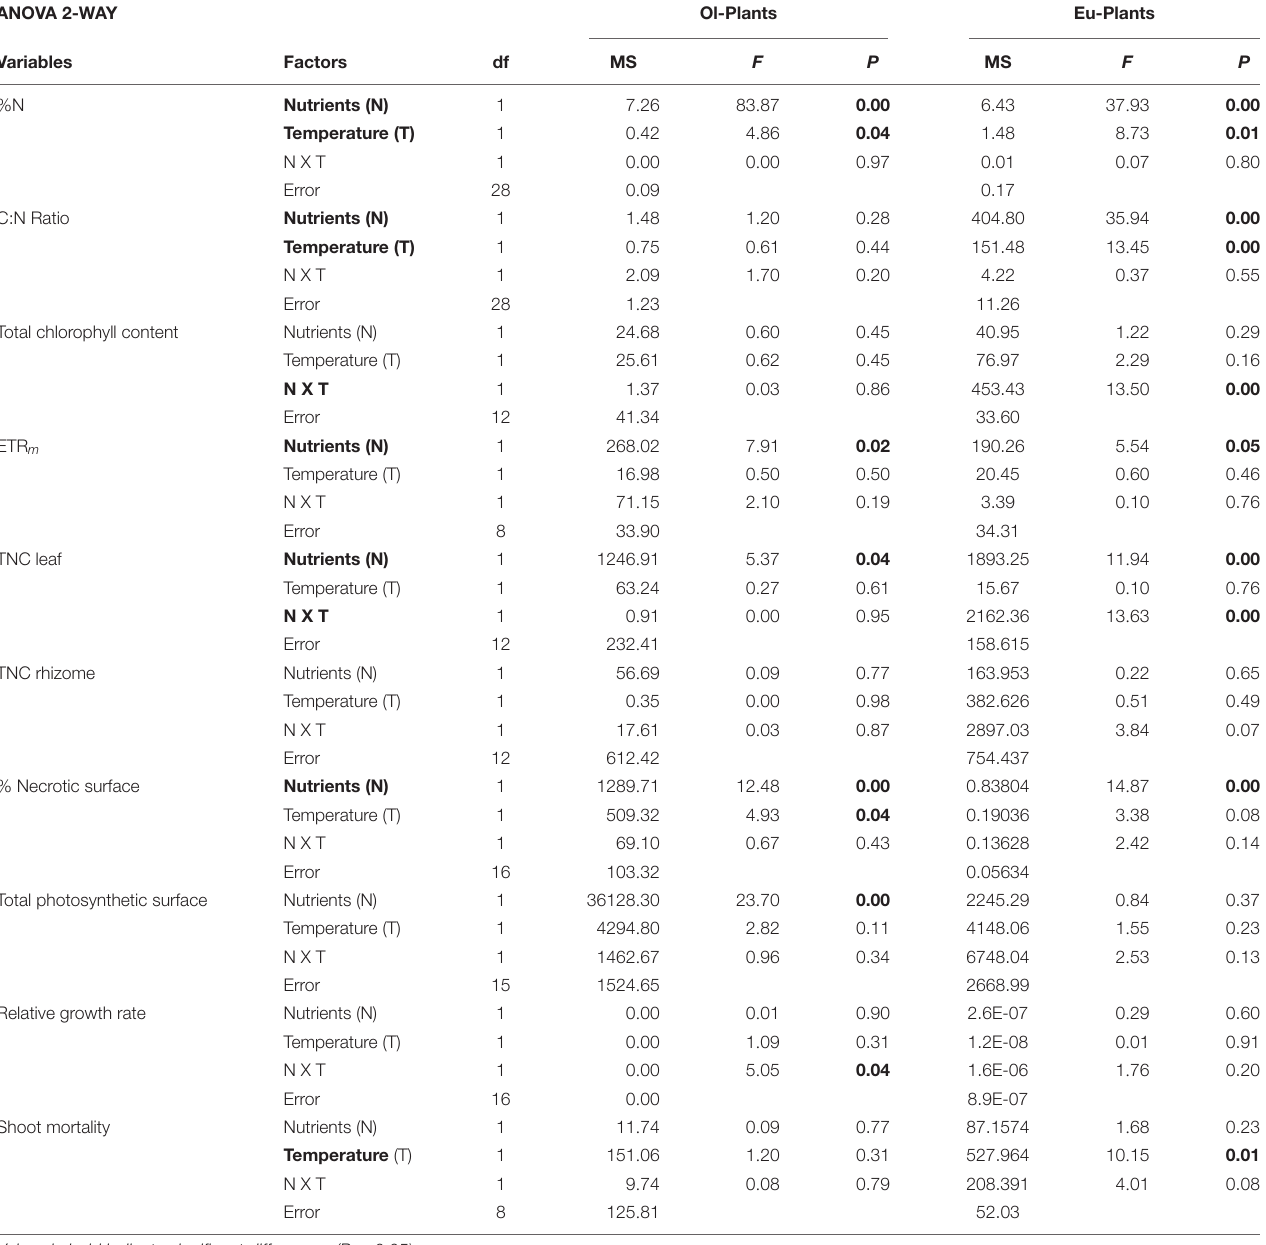
TABLE 1 | Results of two-way ANOVA analysis in OL and EU for factors “Nutrients” (N) and “Temperature” (T) for nitrogen content (%N), carbon and nitrogen ratio (C:N Ratio), Total chlorophyll, maximum electron transport rate (ETR m ), total non-structural carbohydrates in leaf (TNC leaf) and rhizome (TNC rhizome), % necrotic surface, total photosynthetic surface, relative growth rate and shoot mortality. ANOVA 2-WAY Ol-Plants